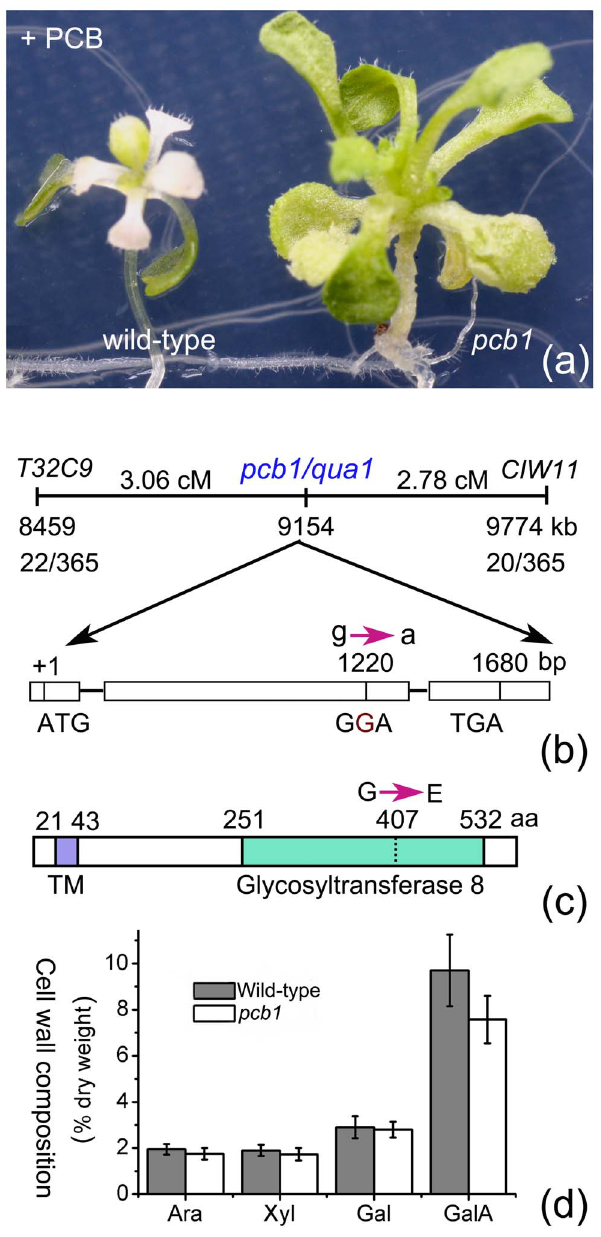
Figure 5. Mutation in a gene required for pectin synthesis led to PCB resistance. (a) A screened pcb1 mutant resistant to the bleach effects of 10 m M PCB 18. Six-d-old Arabidopsis seedlings were transferred to plates containing 10 m M PCB 18 and grown for 2 weeks. (b) Map-based cloning of pcb1 revealed it was a new allele of quasimodo1 and had a G- to A- transition in its second exon. The positions of each locus in chromosome 3 of Arabidopsis and the recombinants in relation to each marker are shown. (c) The PCB1/QUA1 protein had a transmenbrane (TM) domain in the N-terminus and a glycosyltransferase 8 (GT8) domain in the C-terminus, while pcb1 had a mutation in the conserved GT8 domain. (d) The arabinose (Ara), xylose (Xyl), and galactose (Gal) contents in 12-d-old seedlings of pcb1 were comparable to the wild-type, but the GalA content showed a , 20% reduction.